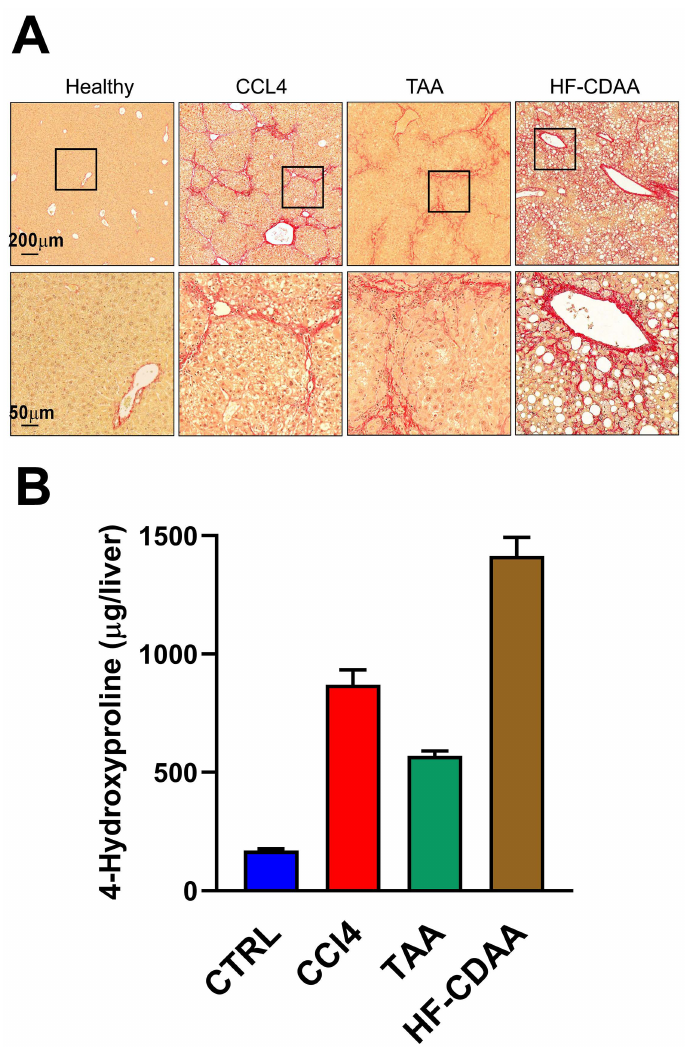
Figure 2. ( A ). Histologically distinct hepatic fibrosis patterns in three utilized chronic liver injury models. Liver sections were prepared from healthy animals, mice subjected to repeated administration carbon tetrachloride (CCl4), thioacetamide (TAA) and feeding with choline-deficient, amino-acid- defined, 60% high-fat diet (HF-CDAA), respectively. Representative low- (top, × 50) and high (bottom, × 200)-magnification images of collagen staining (Sirius red) demonstrated robust “post- necrotic type” bridging fibrosis in livers with CCL4 and TAA-induced models. Advanced “chicken wire” perisinusoidal fibrosis characteristic of “metabolic-type” fibrosis observed in NAFLD/NASH develops in livers of HF-CDAA-fed mice. Healthy liver from untreated strain-, sex-, and age-matched mice used as control for comparison. Scale bar: 200 µ m (top), 50 µ m (bottom). ( B ). 4-Hydroxyproline levels ( µ g/liver) for control-diet-fed (CTRL; 6 h), CCl4-treated (CCl4; 6 h), TAA-treated (TAA; 6 h), and HF-CDAA-diet-fed (HF-CDAA; 8 h). Differences between CTRL and each treatment group p < 0.0001 (Mann–Whitney